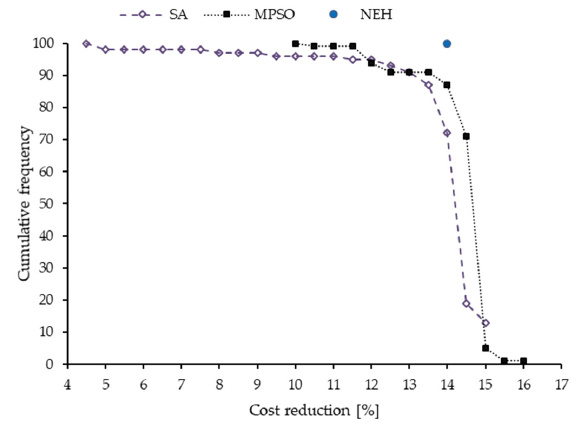
Figure 11. Performance comparison of modified particle swarm optimization (MPSO), simulated annealing (SA), and Nawaz-Enscore-Ham (NEH) to solve problem I.